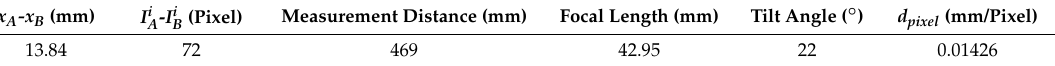
Table 16. Field test cases.